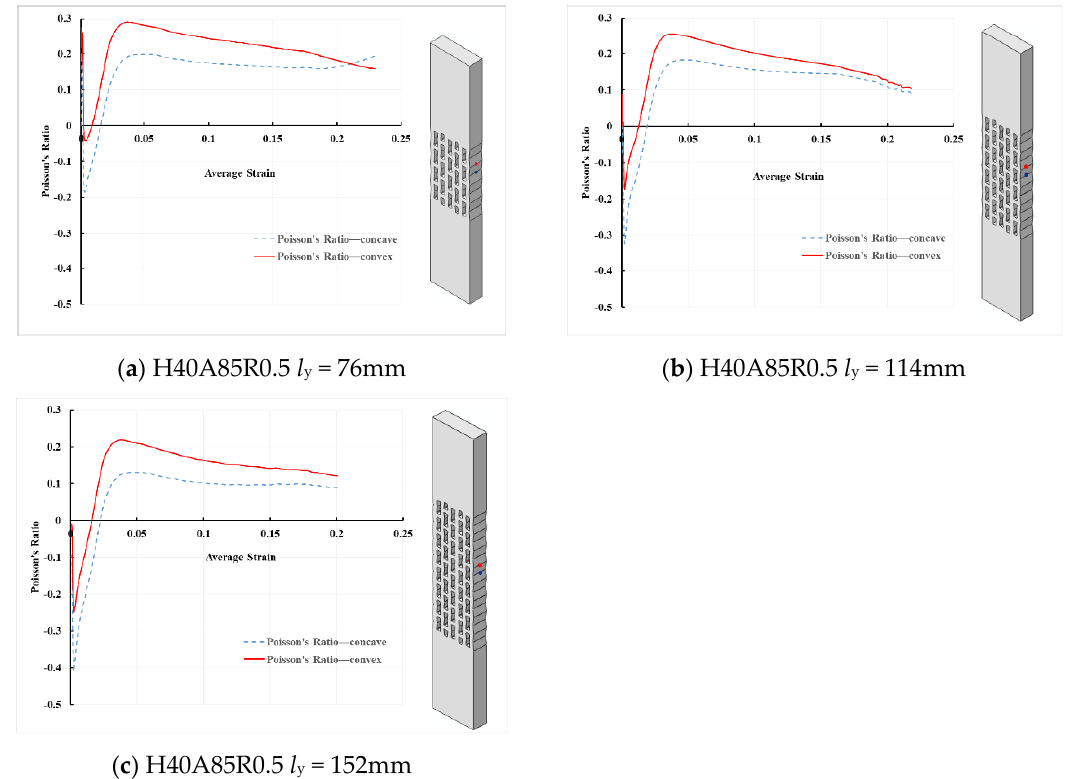
Figure 27. Poisson’s ratio curves of specimens with different perforated areas with (a) l y = 76mm, (b) l y = 114mm and (c) l y = 152mm .